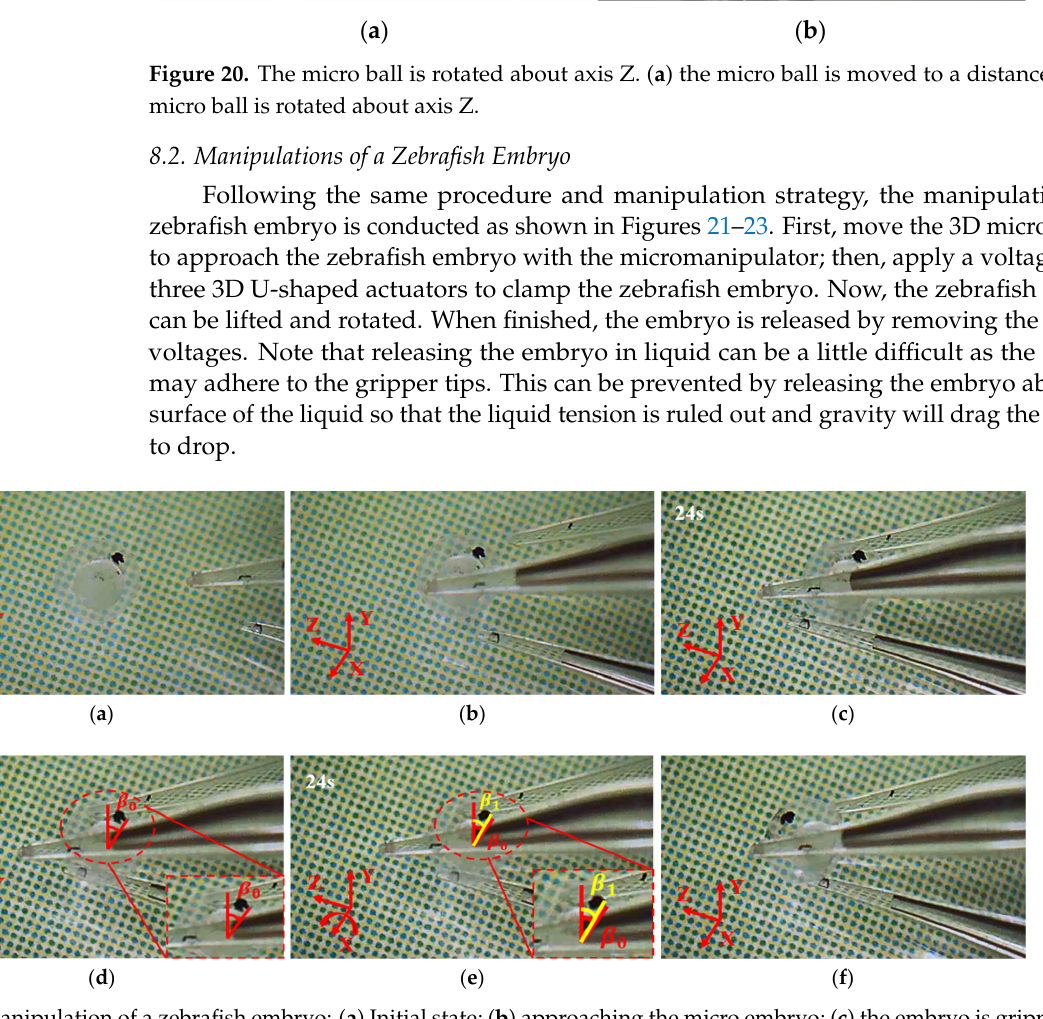
Figure 20. The micro ball is rotated about axis Z. ( a ) the micro ball is moved to a distance; ( b ) the micro ball is rotated about axis Z.